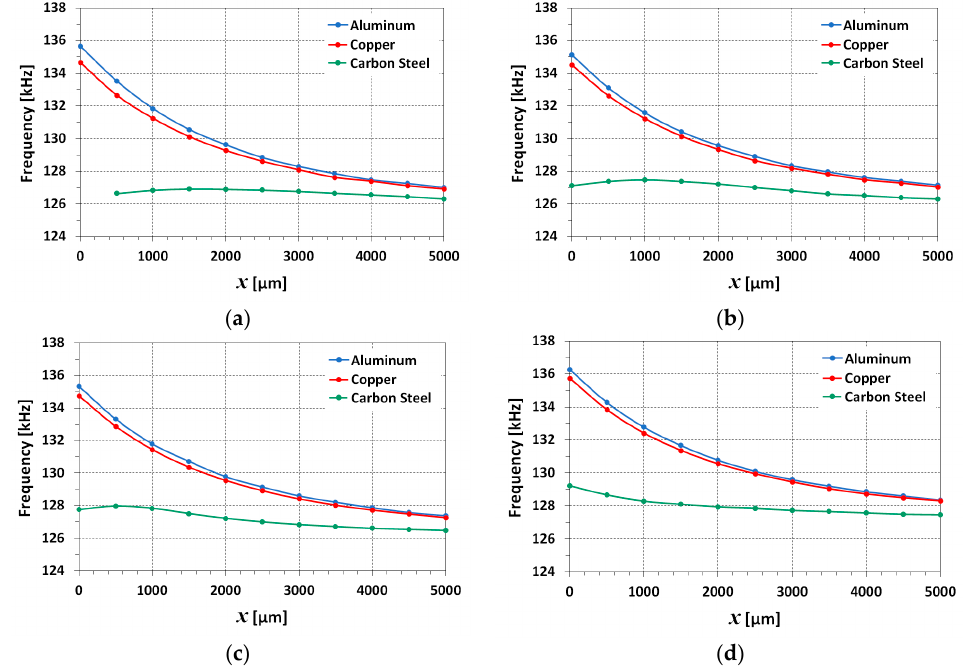
Figure 8. Comparison of the measured LC-tank oscillation frequency, f , for the three considered 1 mm thick targets over the whole considered measurement range of 0–5 mm for different values of V SUPPLY . ( a ) V SUPPLY = 50 mV, ( b ) V SUPPLY = 75 mV, ( c ) V SUPPLY = 100 mV, ( d ) V SUPPLY = 200